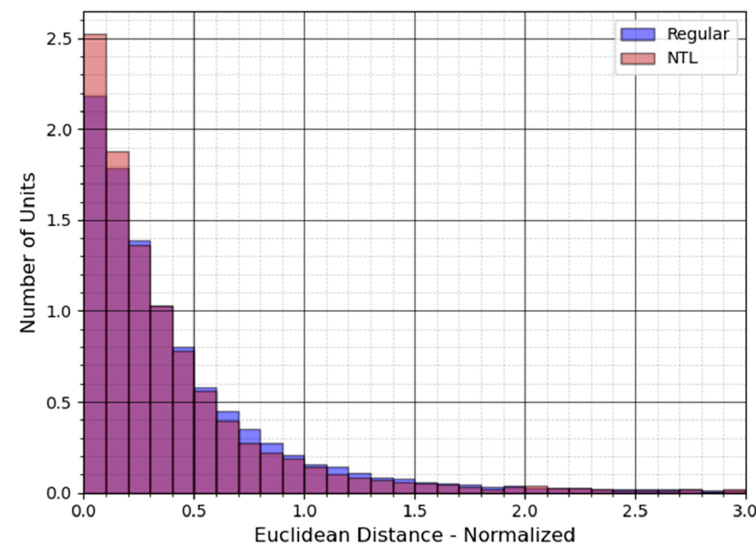
Figure 8. DB Euclidian distance distribution.